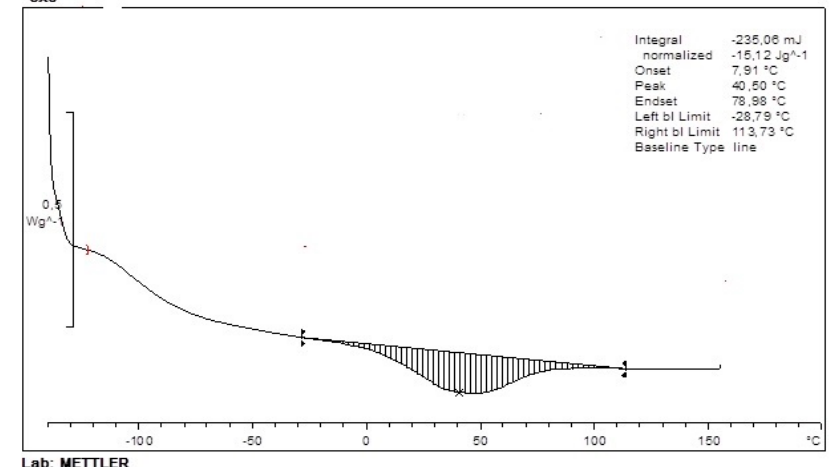
Figure 1. Differential scanning calorimetry (DSC) data for fluoropolyurethane 5 .